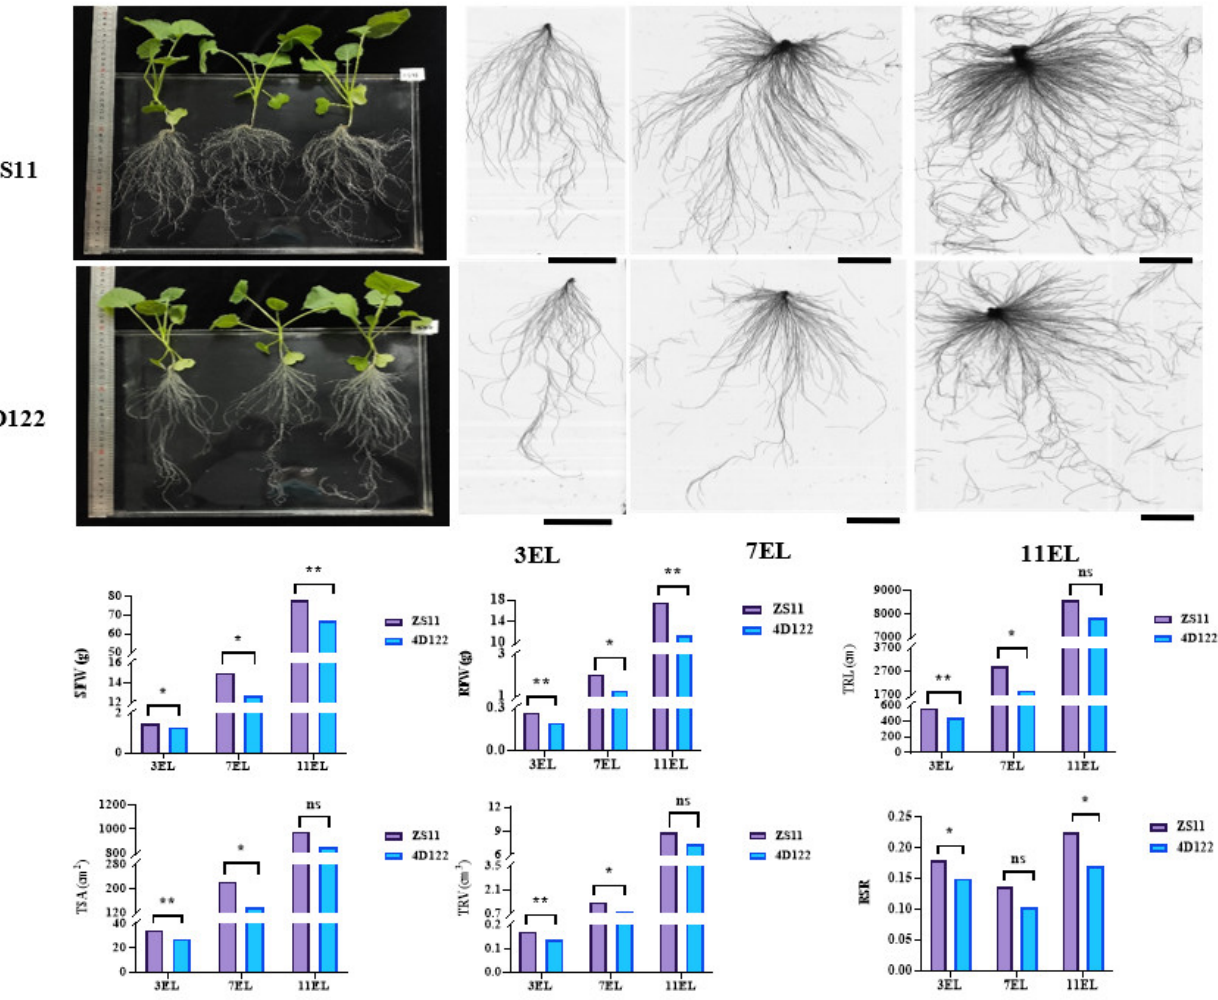
Figure 1. Comparison of phenotypic characteristics of two parents, ZS11 and 4D122. The whole plant performance of the two parents was cultured on the 18th day of the three expanding leaves (3 EL). The root scanning images of the two parents were present at 18, 32, and 46 days old with three, seven, and eleven expanding leaves (3EL, 7EL, and 11EL), respectively. The bars are 5 cm. ** and * indicate significance at the 1% and 5% levels of probability, respectively, while ns indicates non-significant difference.